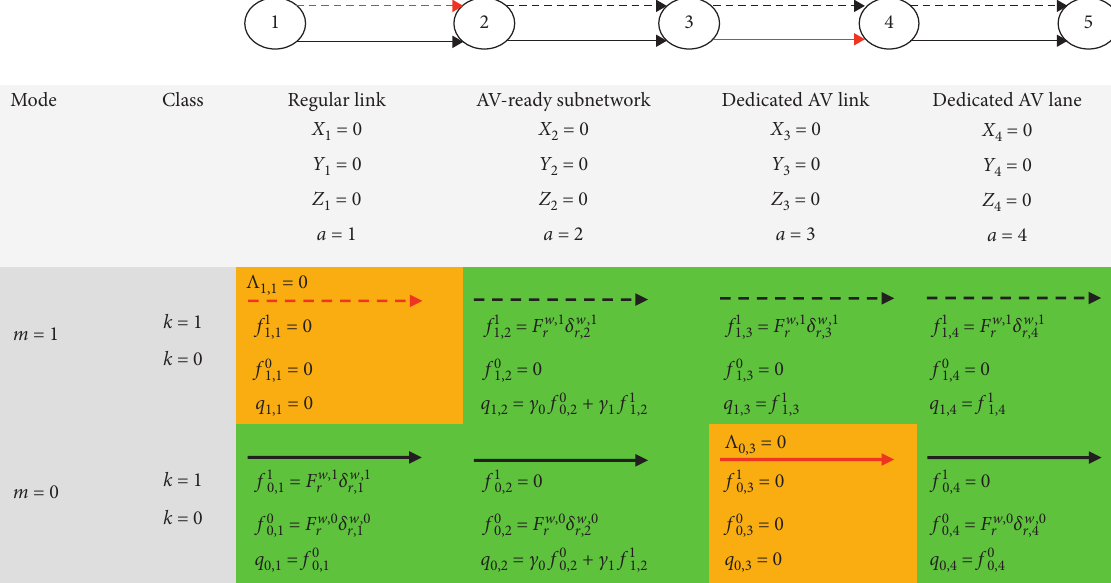
Figure 1: Summary of capacities and flows applied for each mode and class on each link type (links shown with red have a zero capacity, i.e., they are excluded from the traffic